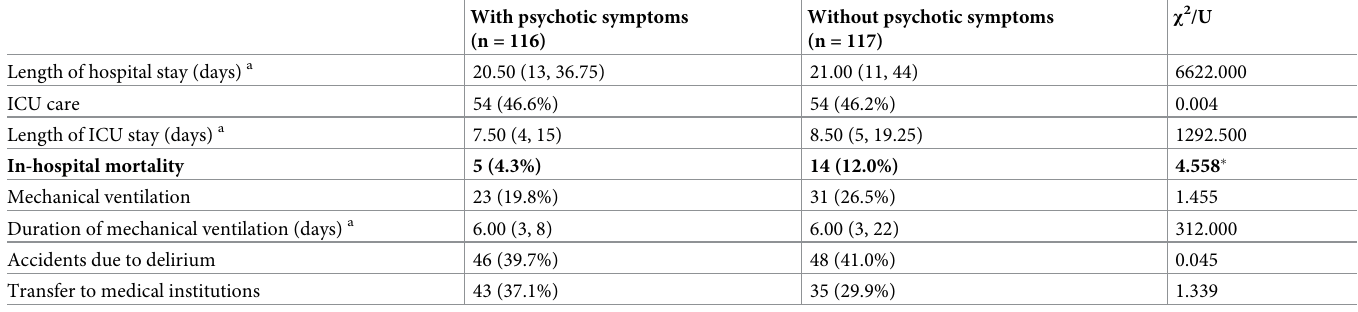
Table 2. Comparisons of clinical